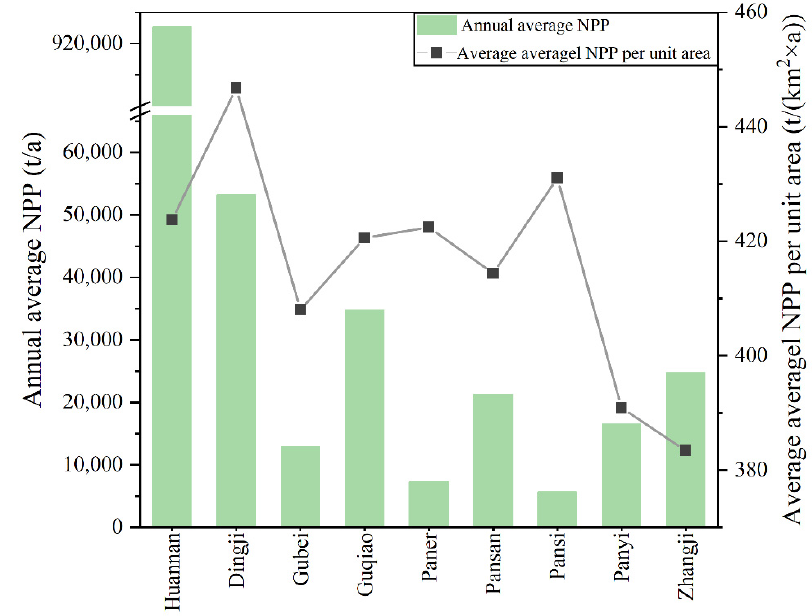
Figure 5. Average NPP and NPP per unit area for each mine in the study area and in Huainan.